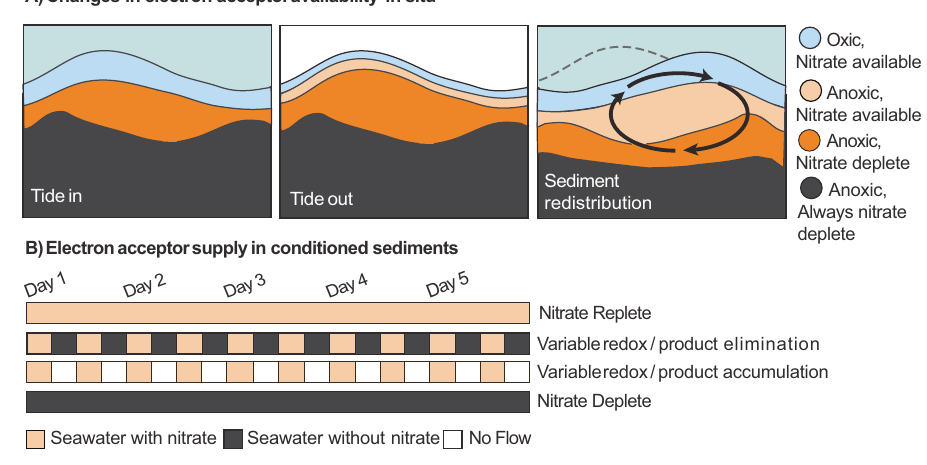
Fig. 1 Exposure of the microbial community to variable NO 3- conditions in intertidal sand fl ats. A Changes in electron availability in situ. Schematic of the changes that occur on hourly to daily time scales on intertidal sand fl ats. When the tide is in, advection can transport O 2 and NO 3- to depths of up to 5 – 10 cm. When the tide goes out, both are rapidly consumed and are only present in the upper mm to cm. When bottom currents become strong enough, or when wave action is high, the rippled sediment structures start to migrate, redistributing sand and exposing deeper sediments which have been NO 3- deplete for longer time periods. B Electron acceptor supply in the conditioned sediments: In addition to carrying out rate measurements on freshly collected sediments, sediments were exposed to different conditions over fi ve days in fl ow-through reactors supplied with anoxic